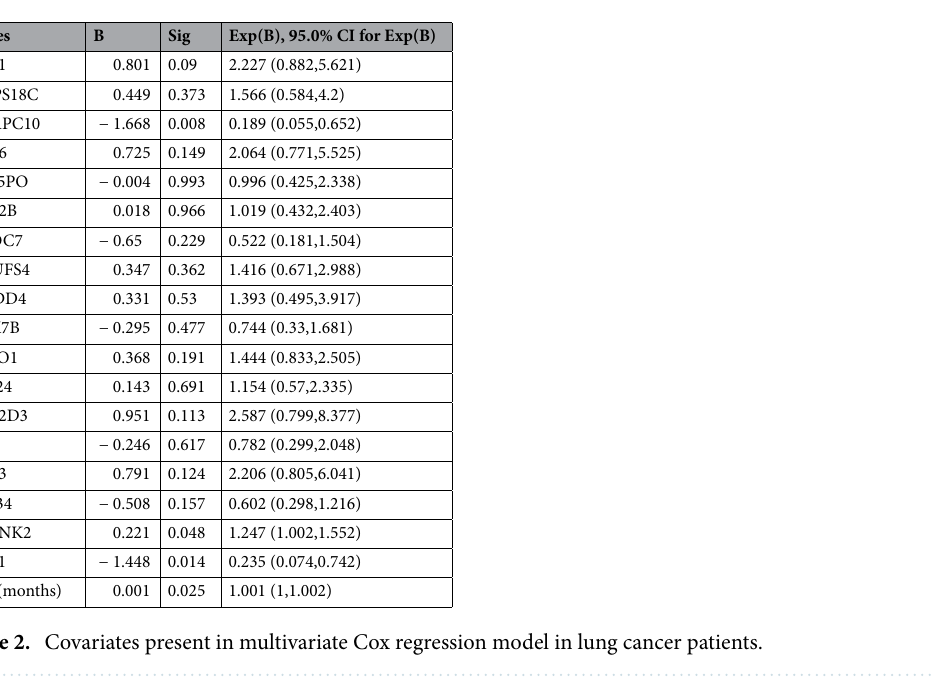
Figure 3. Kaplan–Meier plot and box plot of breast cancer patients risk groups based on the multigene model. ( A ) KM plot showing overall survival in low-risk and high-risk patient groups (Log-rank test p-value = 2.45E−13). The blue line shows the low-risk group, and the red line shows the high-risk group. ( B ) Box plot showing log of FRG1 expression level in low and high-risk groups. The Y-axis represents the log of FRG1 expression, and the X-axis shows the group.